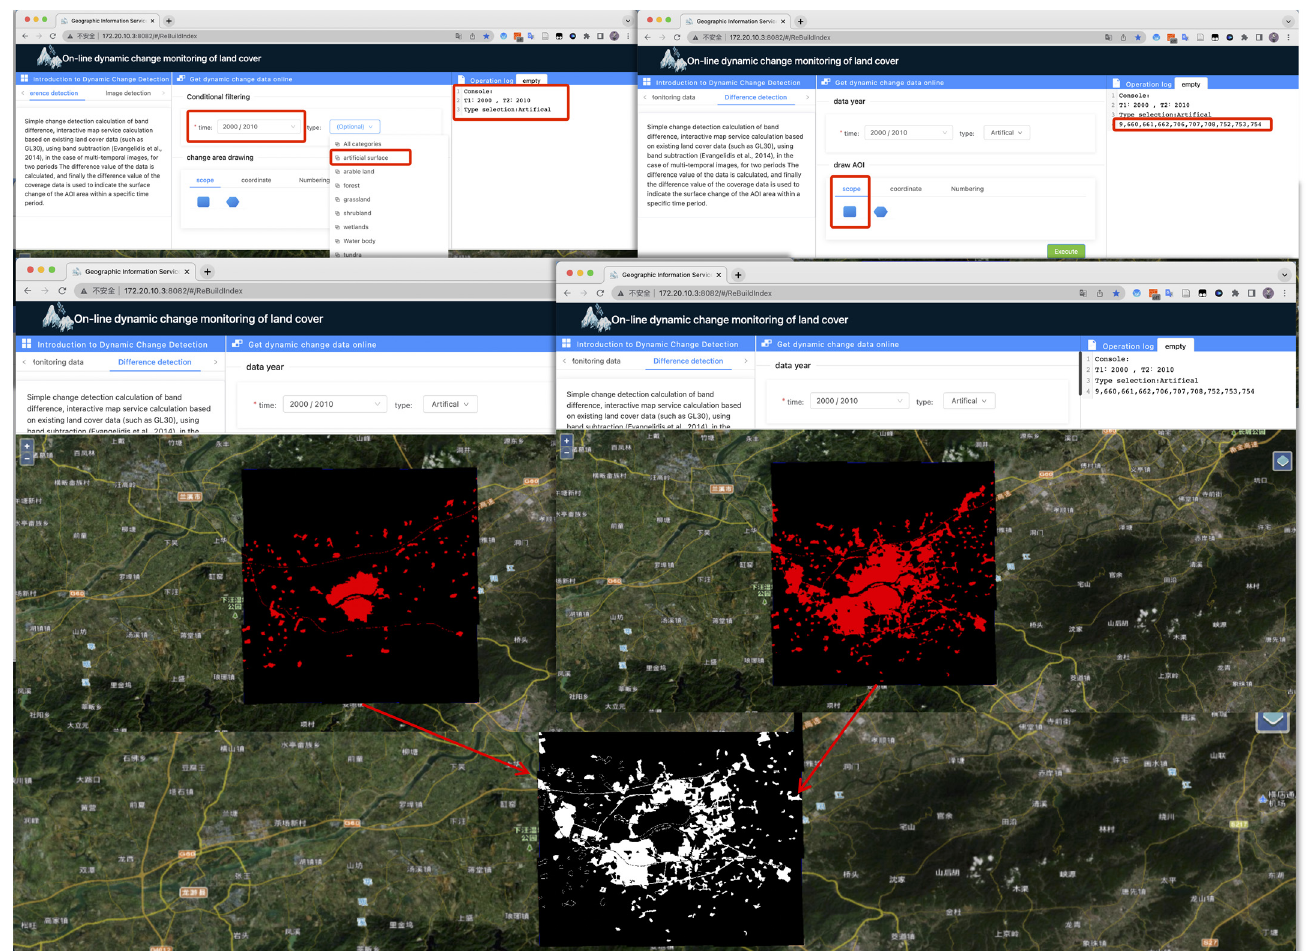
Figure 12. Application of band subtraction change detection.